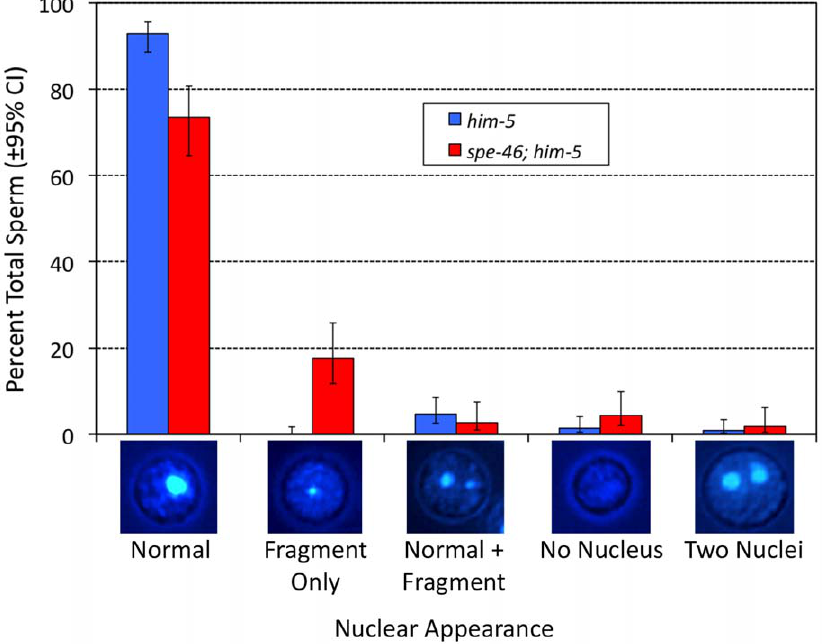
Figure 8. The appearance of nuclei in spermatids labeled with Hoechst 33342. Sperm were observed under epifluorescence, and multiple images were taken at various focal planes to ensure all nuclei were observed. The focal planes were combined to produce the images below the graph. The sperm phenotypes are expressed as percent total sperm, and the confidence interval (CI) is indicated.